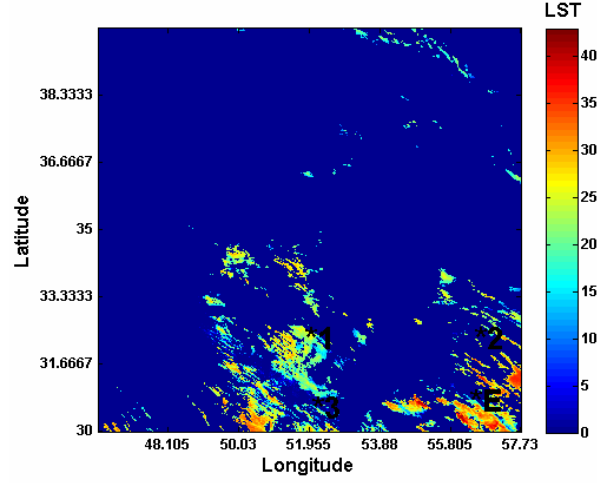
Fig. 7. Daytime LST map around Bam city in Iran on 7 December 2003. A black asterisk with “E” letter represents the earthquake Figure 7. Daytime LST map around Bam city in Iran on 07 December 2003. A black asterisk with 3 epicenter. Other black asterisks represent the selected regions for ‘E’ letter represents the earthquake epicenter. Other black asterisks represent the selected regions 4 studying LST variations during the studied dates. to study LST variations during the studied dates. 5